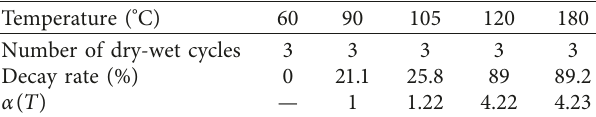
Table 1: Effect of constant temperature on rock decay rates (%).